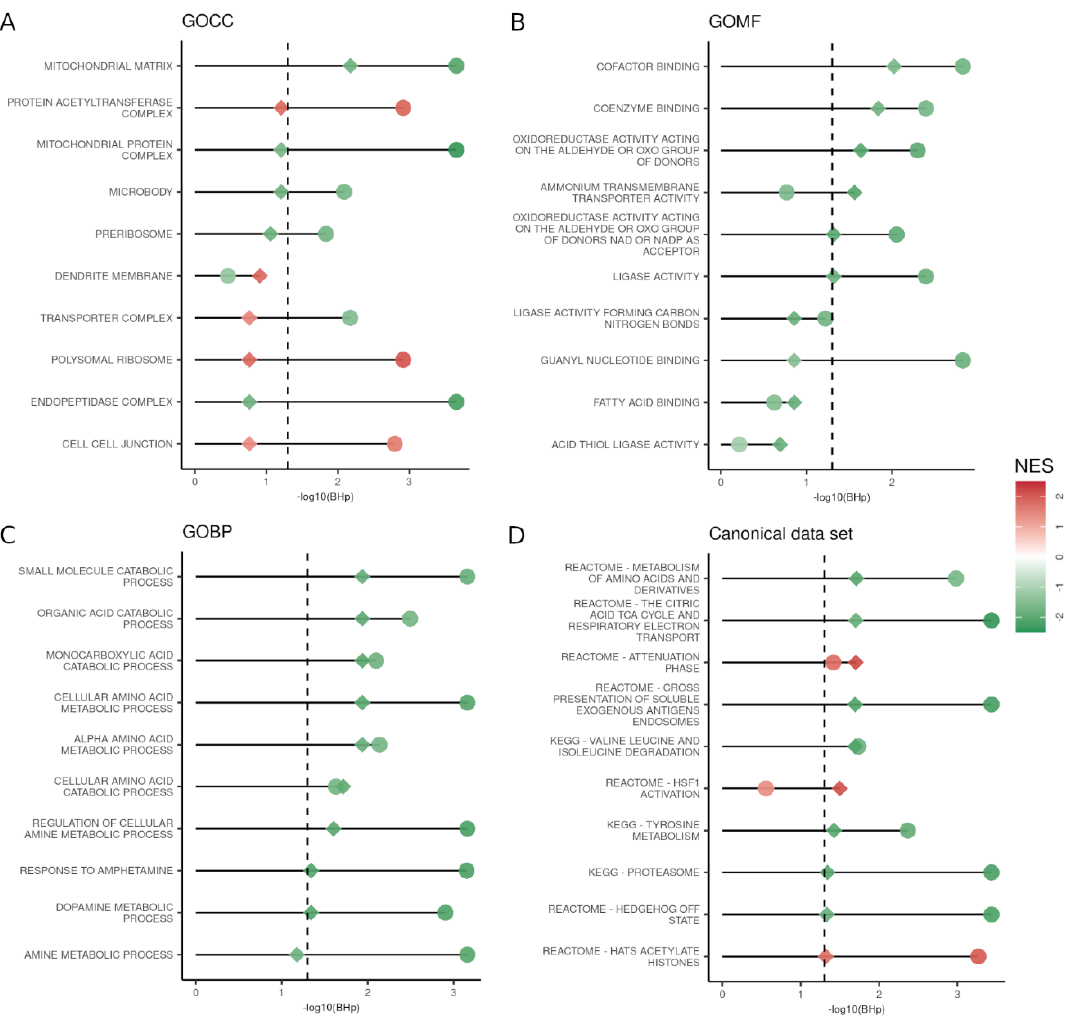
Figure 3. Comparison of the GSEA for the genes ranked by the two linear mixed models (LMMs). Top 10 significant hits of the cell proportion-aware (second) LMM (diamond) compared with their respective values from the cell proportion-unaware (first) LMM (circle). Each shape is colored by the normalized enriched scores (NES); − log 10 of the adjusted p -value is reported on the x -axis. The significance threshold (BHp = 0.05) is indicated by the dashed vertical line. ( A ) Top results for gene ontology cellular component (GOCC); ( B ) Top results for gene ontology molecular function (GOMF); ( C ) Top results for gene ontology biological process (GOBP); ( D ) Top results for canonical data set.